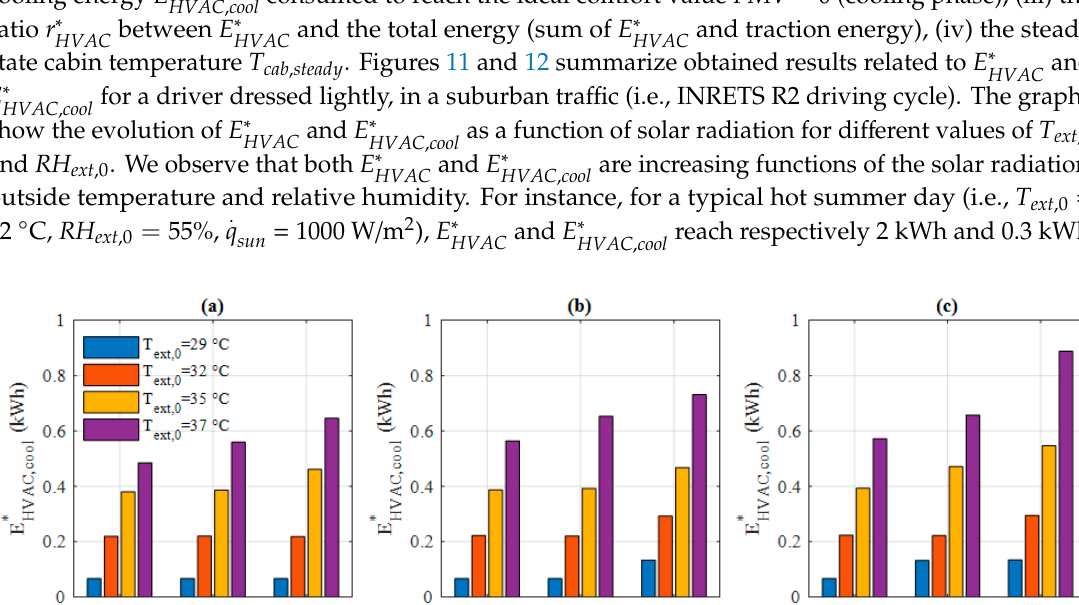
Figure 12. HVAC system consumption (cid:1831) (cid:3009)(cid:3023)(cid:3002)(cid:3004) ∗